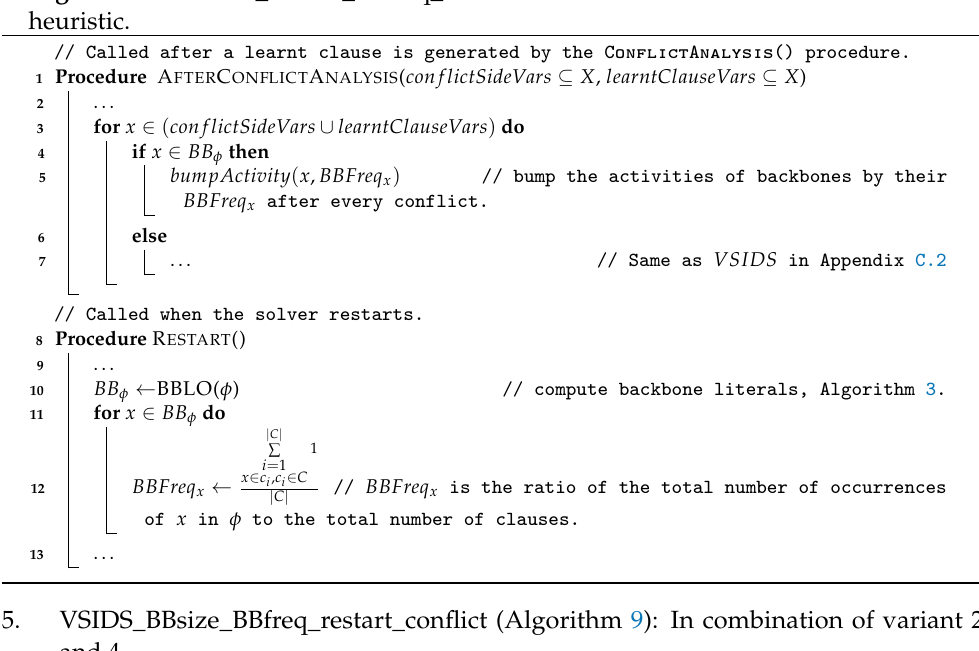
Algorithm 8: VSIDS_BBsize_BBfreq_conflict a variant of the VSIDS decision heuristic.